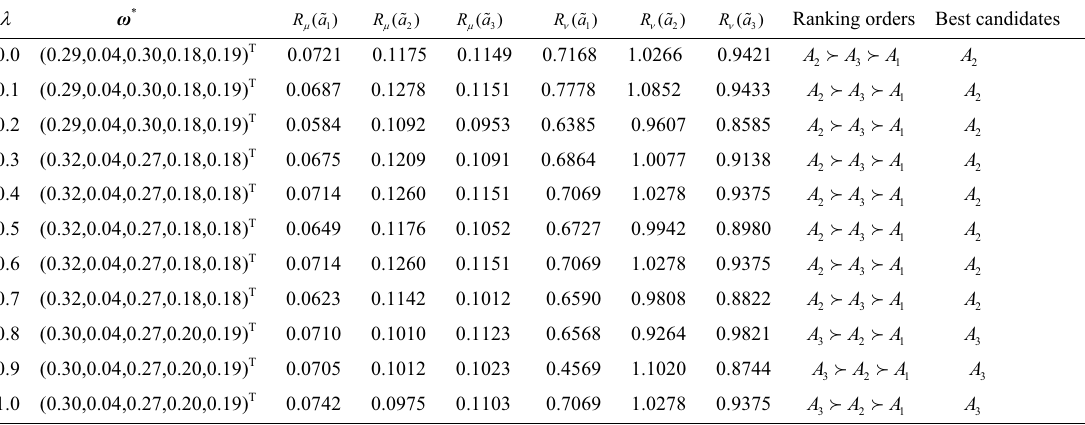
Table 7 The computation results for different risk attitude parameter values and ranking orders of candidates